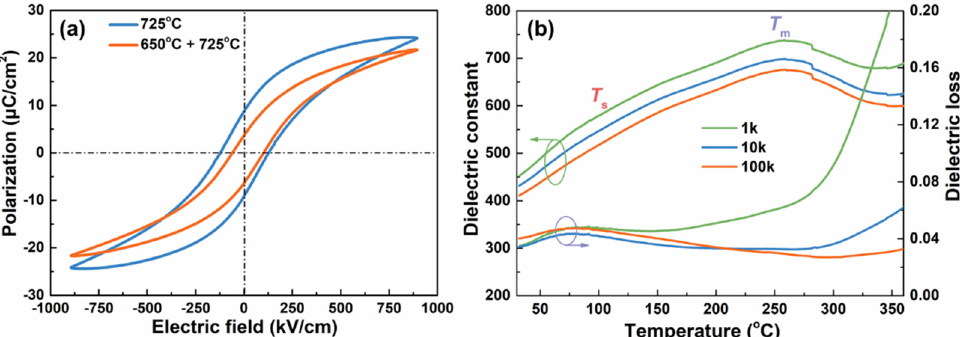
Figure 5. ( a ) Ferroelectric hysteresis ( P – E ) loops of the BNT–5.5BZ thin films annealed under differ- ent conditions and ( b ) dielectric constant and loss as a function of temperature for the “650 °C + 725 °C” thin